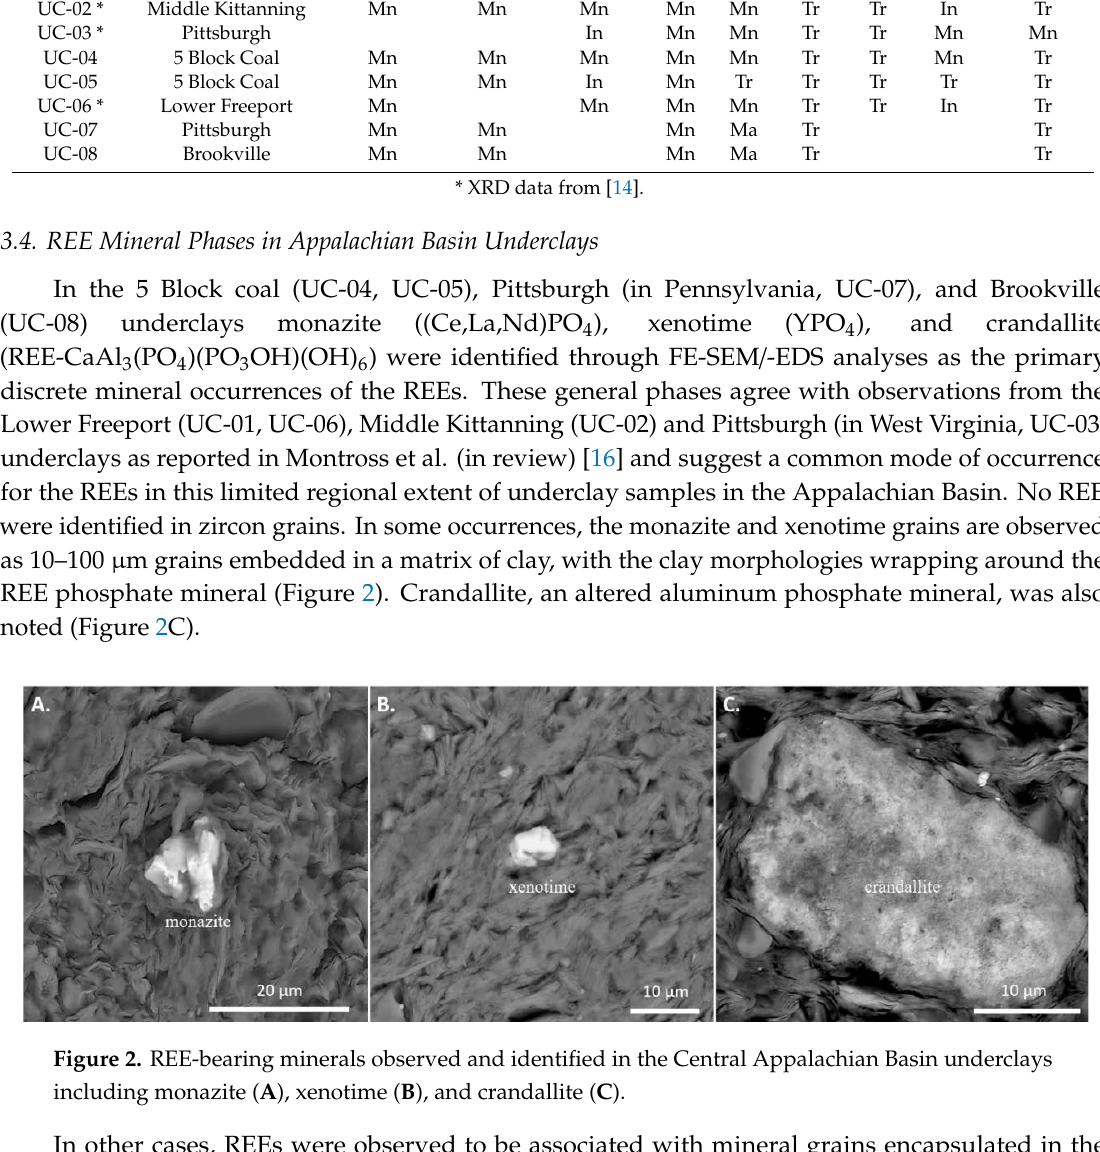
Table 4. Semi-quantitative XRD results: Major (Ma) (>50%)-Intermediate (In) (25–50%) Minor (Mn) (5–25%)-Trace (Tr) (<5%). Qtz = quartz, Kspar = potassium (K) feldspar, Plag = plagioclase (Ca/Na) feldspar.